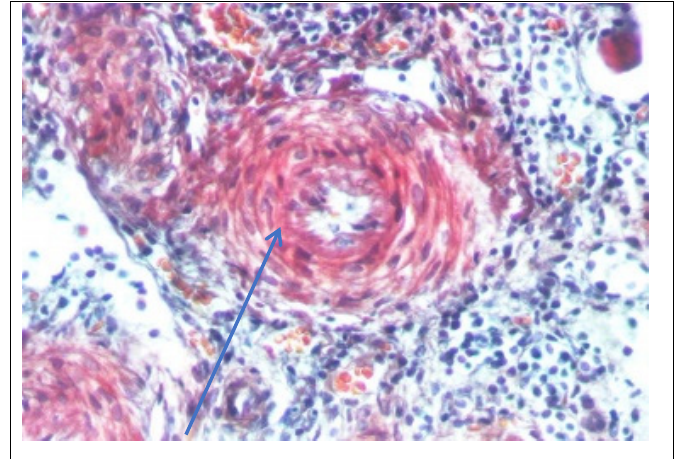
Figure 6. Kidney biopsy (Trichrome staining × 200)—Vessel with thickened wall (blue arrow).